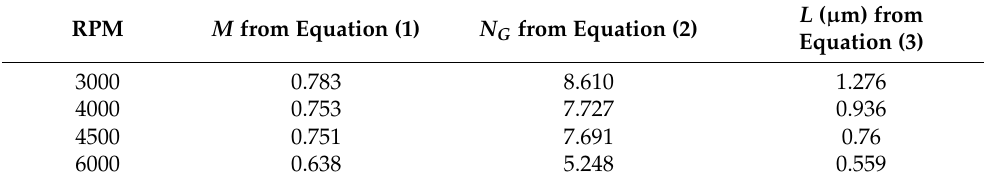
Figure 7. ( a ) Raman spectra of the prepared FFG at different rotational speeds using shear exfoliation; ( b ) magnified 2D bands of the spectra. Table 1. Effect of rotational speed of high-shear mixer on FFG quality indicators determined using Raman spectroscopy.